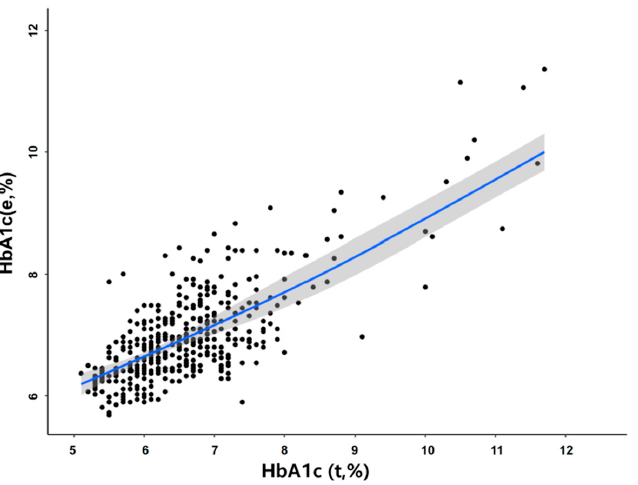
Figure 5. Multivariate linear regression relationship between glycosylated hemoglobin detection value and HbA1c estimated value in patients with type 2 diabetes mellitus (T2DM). HbA1c (esti- mated)% = (average blood glucose + 2.5944)/1.5944). HbA1c (corrected) = − 0.035367 × RBCs + 1.010689 × HbA1c (test) + 2.953272 (R 2 = 0.772).